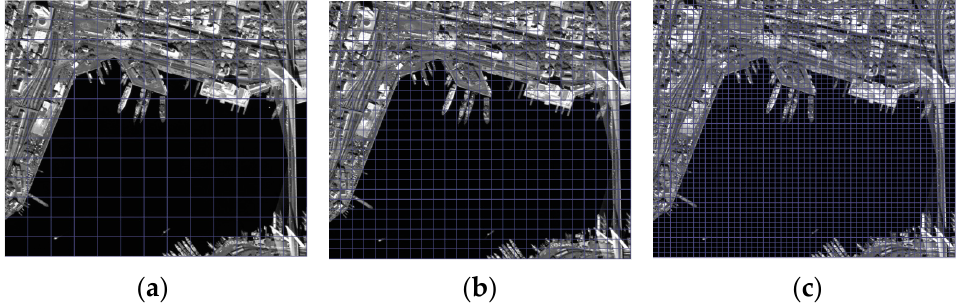
Figure 2. Receptive field of the same aerial remote sensing image at different scales: ( a ) 13 × 13; ( b ) 26 × 26; ( c ) 52 × 52.